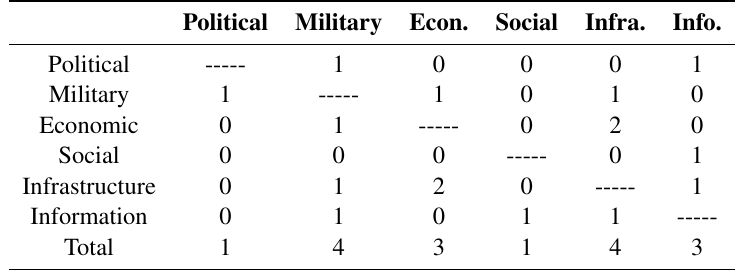
Summary of initial group identification of critical